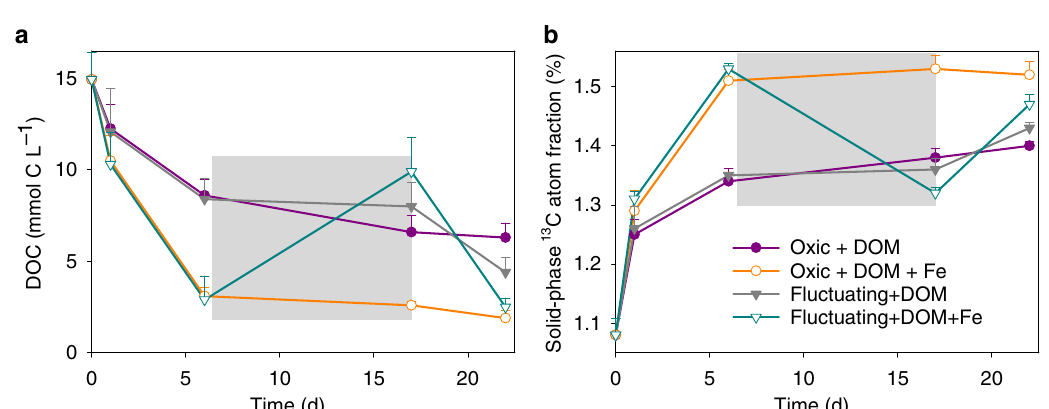
Fig. 5 Dissolved organic carbon concentration and solid-phase 13 C enrichment. a Dissolved organic carbon concentration (MES buffer concentration was subtracted) and b solid-phase 13 C atom fraction from 13 C-DOM addition treatments. The gray shaded region represents the anoxic phase of the redox- fl uctuating treatment. Error bars represent s.e.m. ( n =